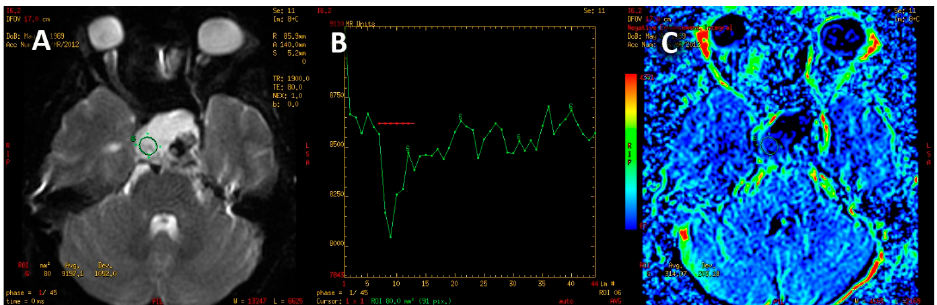
Figure 7. Adamantinomatous craniopharyngioma. PWI image ( A ). T2* signal intensity curve with rapid return, exceeding the baseline signal ( B ). Color-coded map of cerebral blood volume with minor perfusion values within the tumor ( C ).